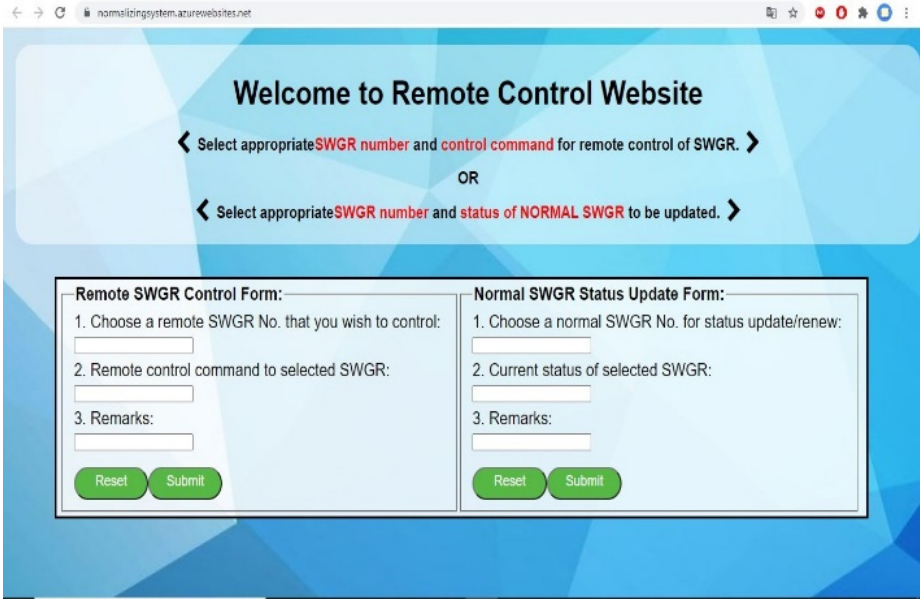
Figure 12. Remote-control website system